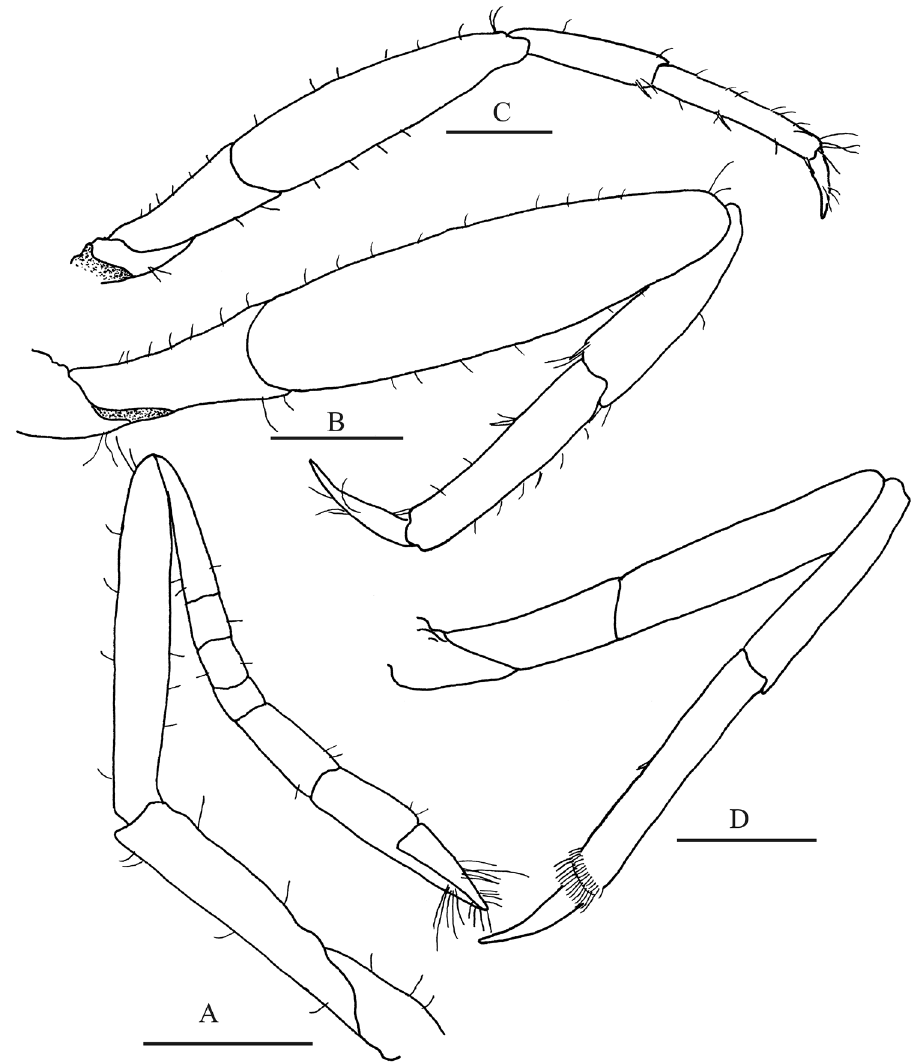
Figure 8. Leptalpheus melendezensis sp. n. Holotype male, CL 4.1 mm (EMU-10582); A second pereo- pod, lateral view B third pereopod, lateral view C fourth pereopod, lateral view D fifth pereopod, lateral view. Scale bar 0.5